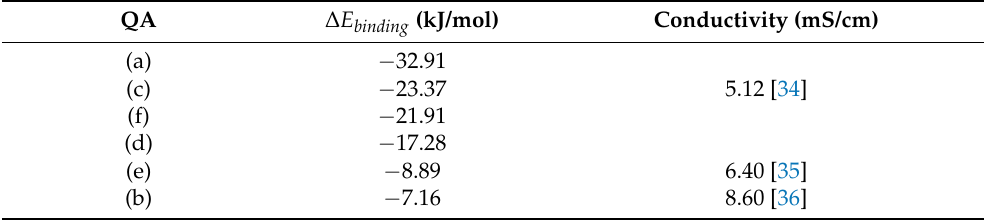
Table 1. Values for ∆ E Binding of QA head groups with hydroxide ions, and the values for experi- mental conductivity (see Table S1 in the Supplementary Materials for detailed contributions to the binding